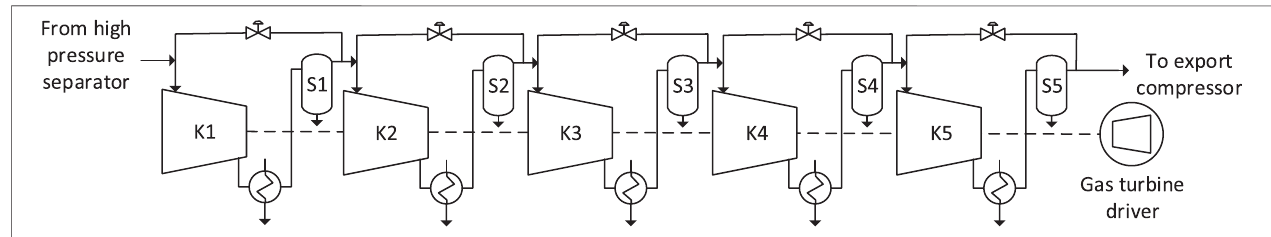
FIGURE 6 | Simpli fi ed schematic of a multistage gas compressor train powered by a gas turbine.